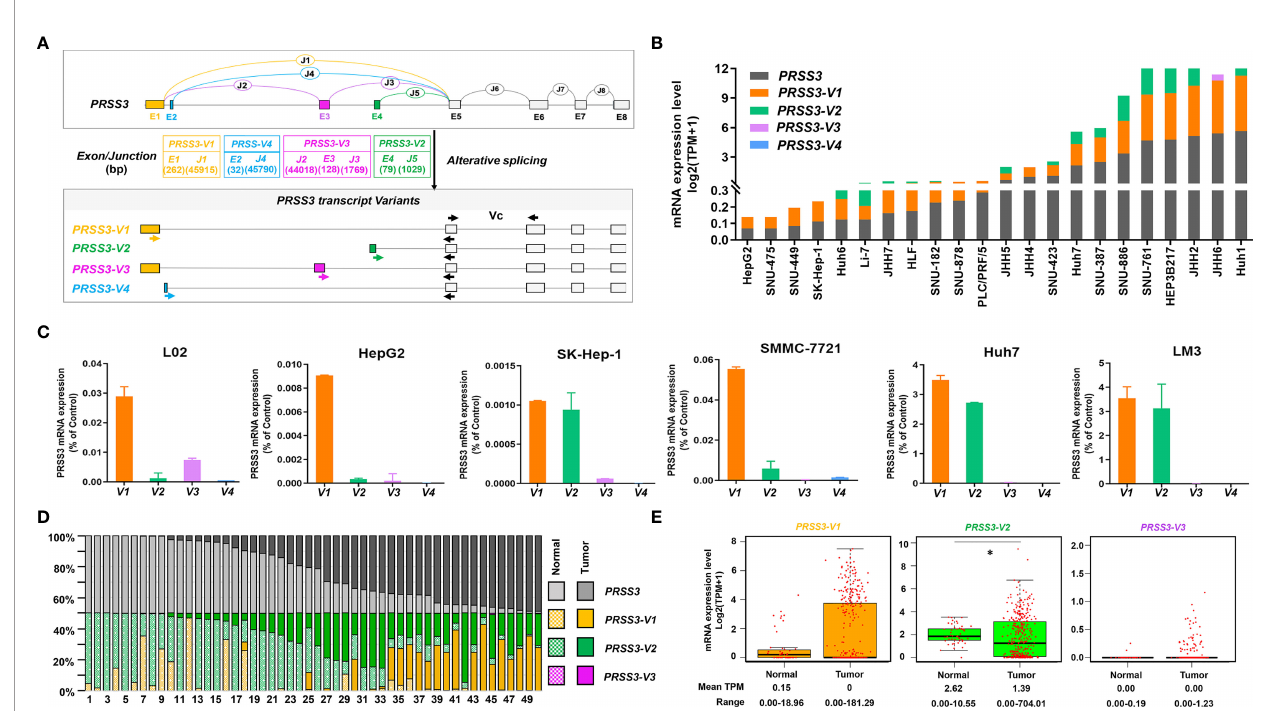
FIGURE 2 | The expression of PRSS3 splice variants in human HCC cells and tissues. (A) A schematic overview of the human PRSS3 gene structure and its splicing variants ( SVs ) and the designed RT – qPCR primers. The top diagram represents the genomic organization of PRSS3 . Alternative splicing within the 5 ’ region of the PRSS3 gene leads to the creation of PRSS3-V1 ~ -V4 . The exons and introns are represented as boxes and lines (not drawn to scale). E1-E8: Exons; J1-J8: Junctions. E5-8: gray boxes common to all four variants. E1 to 4: sequence-speci fi c for PRSS3-V1 (brown) , -V4 (blue) , -V3 (purple), and -V2 (green), respectively. Arrowheads indicate primer set locations used for ampli fi cation of PRSS3 - SVs . Forward primers were designed speci fi cally for PRSS3-SVs . Reverse primers were common to all. Vc : RT – qPCR primer set common to PRSS3-SVs . (B) Expression level of PRSS3-SVs in HCC cell lines. Data from the DepMap ( Table S1 ). (C) RT – qPCR of PRSS3 transcripts expressed in the human fetal liver cell line L02 and HCC cell lines. The relative expression level of each mRNA was normalized against b - actin . (D) Comparison of the mRNA expression of PRSS3 and its transcript variants in 50 paired HCC and normal liver tissues ( Table S2 ). The relative percentage of PRSS3 transcripts expressed in each paired sample (TPM scale) was visualized by a 100% stacked bar graph. (E) The mRNA expression of PRSS3 transcripts in HCC tissues (n=371) and normal liver tissues (n=50) based on data from FIREHOSE. The relative transcript level is presented as a log2 (TPM+1) scale. * P < 0.05 by Wilcoxon rank sum